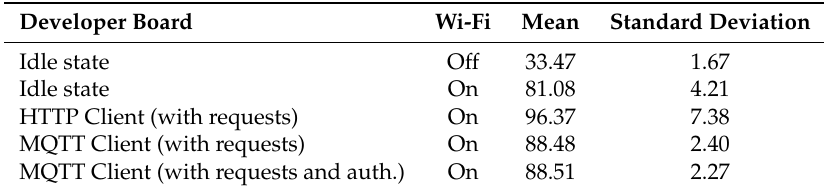
Table 3. Current measures during the experiments